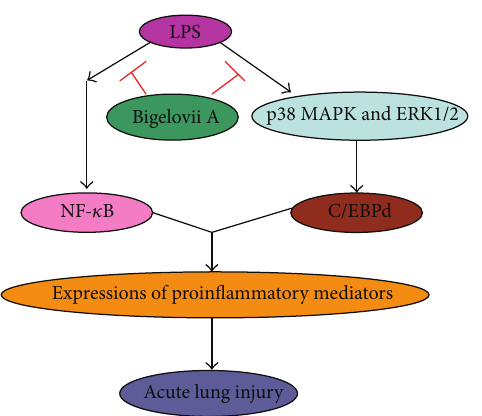
Figure 11: During LPS stimulation, both NF- 𝜅 B and p38 MAPK/ERK1/2—C/EBP 𝛿 pathways are activated, which contribute to production of proinflammatory mediators and acute lung injury. However, Bigelovii A, as a new discovered natural product from the dried herbs of Salicornia bigelovii Torr., can disrupt LPS induction of both signaling pathways, leading to attenuation of inflammatory